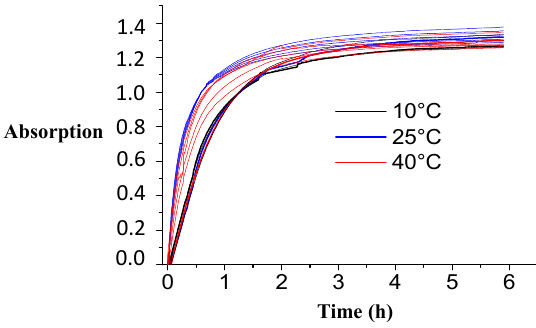
Figure 12. Plots of the experimental kinetic data for different temperatures (GAC ‐ 5; 3.2 g/20 mL of a 6.25% ammonia solution). Table 7. Statistical comparison of the equilibrium absorption value reached for each temperature. Temperature ◦ C A ∗ 10 1.294 25 1.332 40 1.285 Method: 95.0 percent LSD.